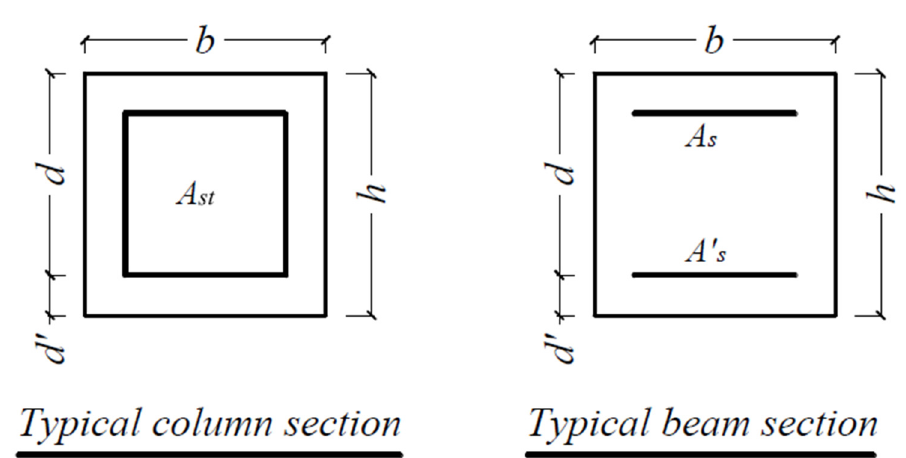
Figure 1. Distribution of longitudinal reinforcement in a typical beam and column section in web- bonding frames [7,28].